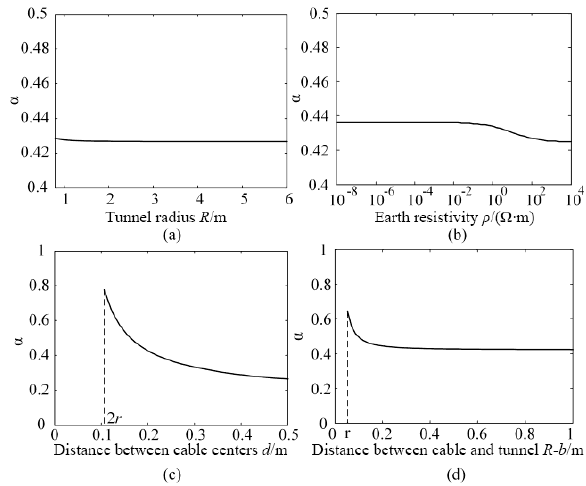
Figure 5. Influence of laying parameters on characteristic admittance ratio α . ( a ) Tunnel radius. ( b ) Earth resistivity. ( c ) Distance between cable centers. ( d ) Distance between cable and tunnel